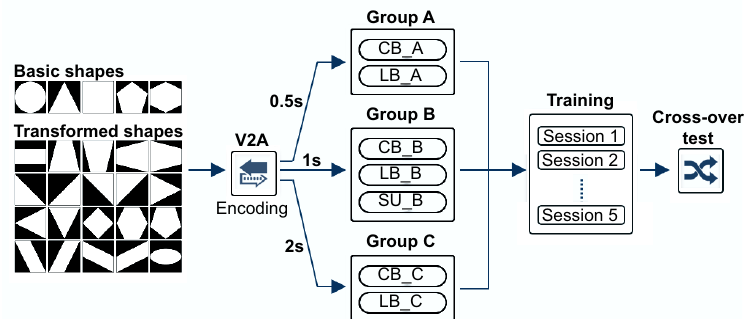
Figure 2. Procedure for experiment on human evaluation. Group A, B, and C refer to groups of participants who trained with sounds encoded in 0.5, 1 and 2 s, respectively, through the vOICe. Each group consists of five participants with congenital blindness (CB) and late blindness (LB). Sighted users (SU) additionally participated in Group B for reference purposes and for comparison of the results of the